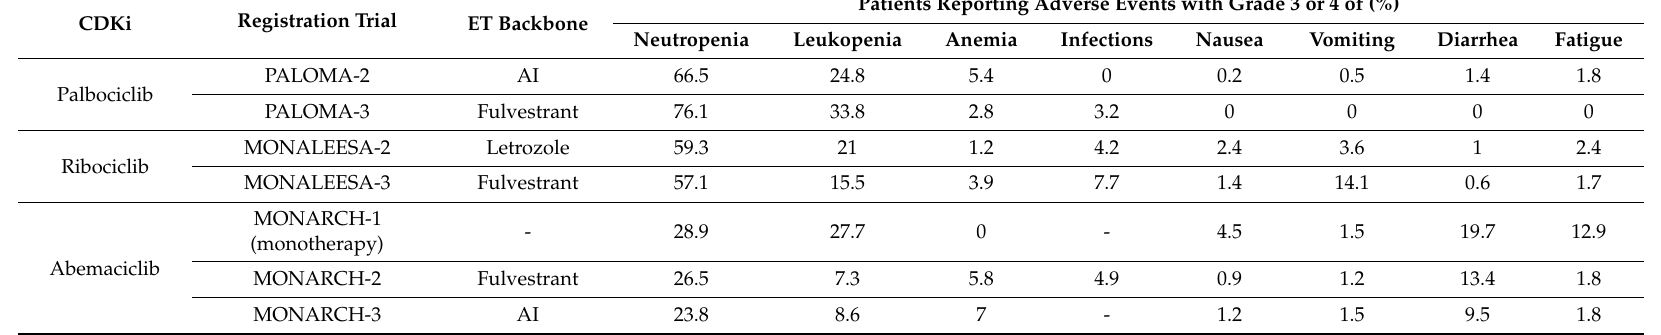
Table 2. Summary of more relevant adverse events (grade 3 or 4 according to NCI-CTCAE) in registration trials of palbociclib, ribociclib and abemaciclib. CDKi, CDK4 / 6 inhibitor; ET, endocrine therapy; AI, aromatase